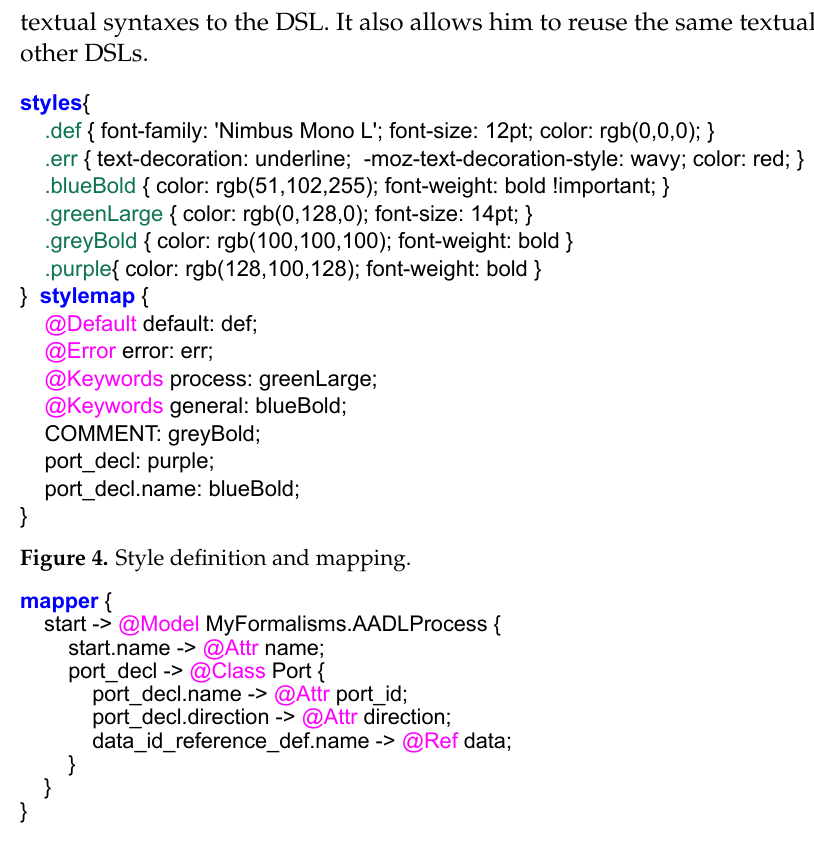
Figure 5. Excerpt of the metamodel mapping for AADL processes.